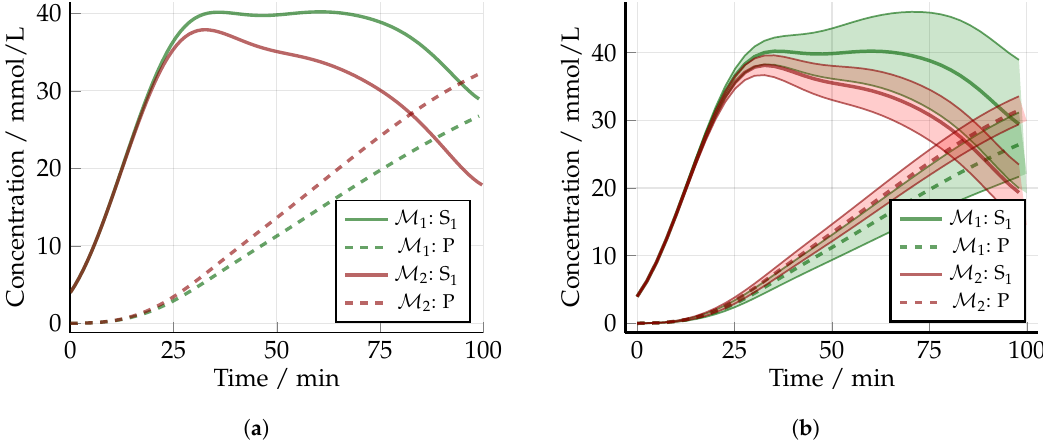
Figure 6. Measured states for the nominal design. ( a ) Output trajectories neglecting parameter uncertainties; ( b ) Confidence intervals due to parameter uncertainties.